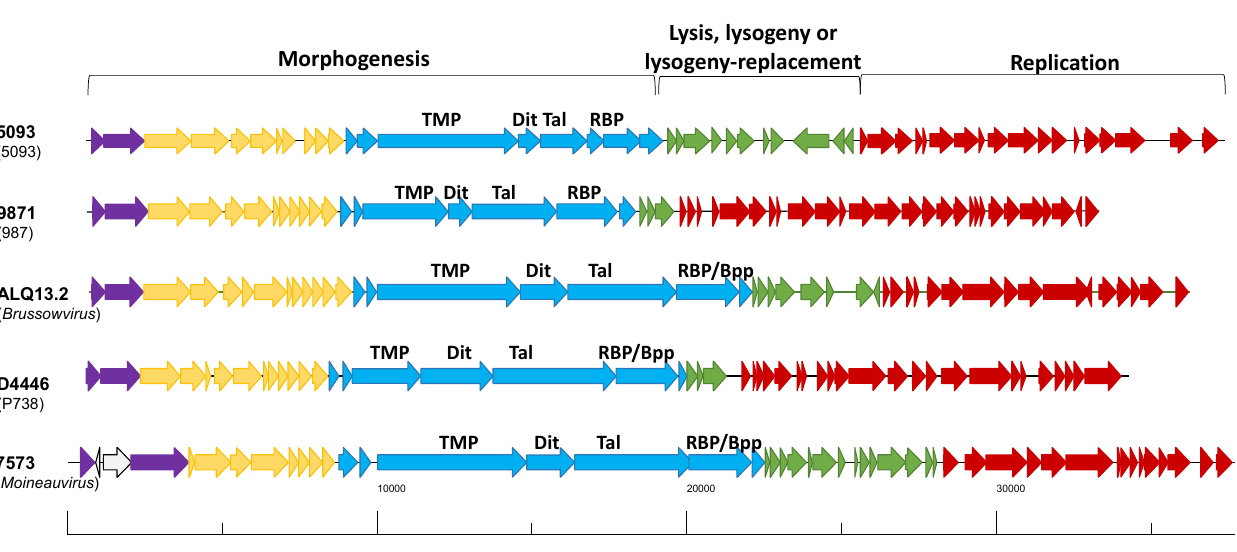
Figure 2. Schematic depicting the genome organization of representatives of each of the five dairy streptococcal phage groups, i.e., 5093 (5093 group); 9871 (987 group); ALQ13.2 ( Brussowvirus ); D4446 (P738 group); and 7573 ( Moineauvirus ). Each arrow represents a gene, and the arrows are colour-coded to identify the functional module to which they belong, i.e., the morphogenesis module encompassing DNA packaging (purple), capsid morphogenesis and head-to-tail joining (yellow) and tail morphogenesis (blue) functions; the lysis and lysogeny or lysogeny-replacement module (green) and DNA replication (red). The genomes are drawn according to the scale indicated below the schematic.